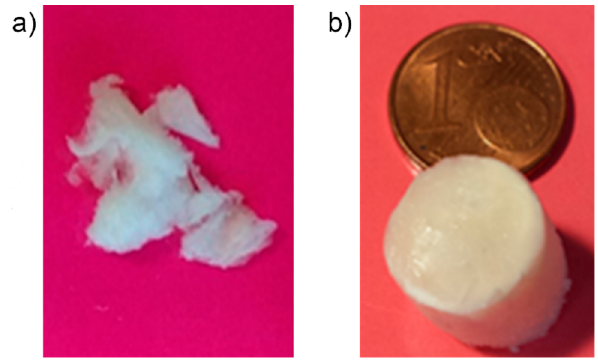
Figure 3. Cryogels from the modified PS as obtained from variable 2,2,6,6-tetramethyl-1-piperidinyl-1- oxy radical (TEMPO) / laccase ratio as shown in Table 1: ( a ) sample B; ( b ) sample C. Cryogel Morphology